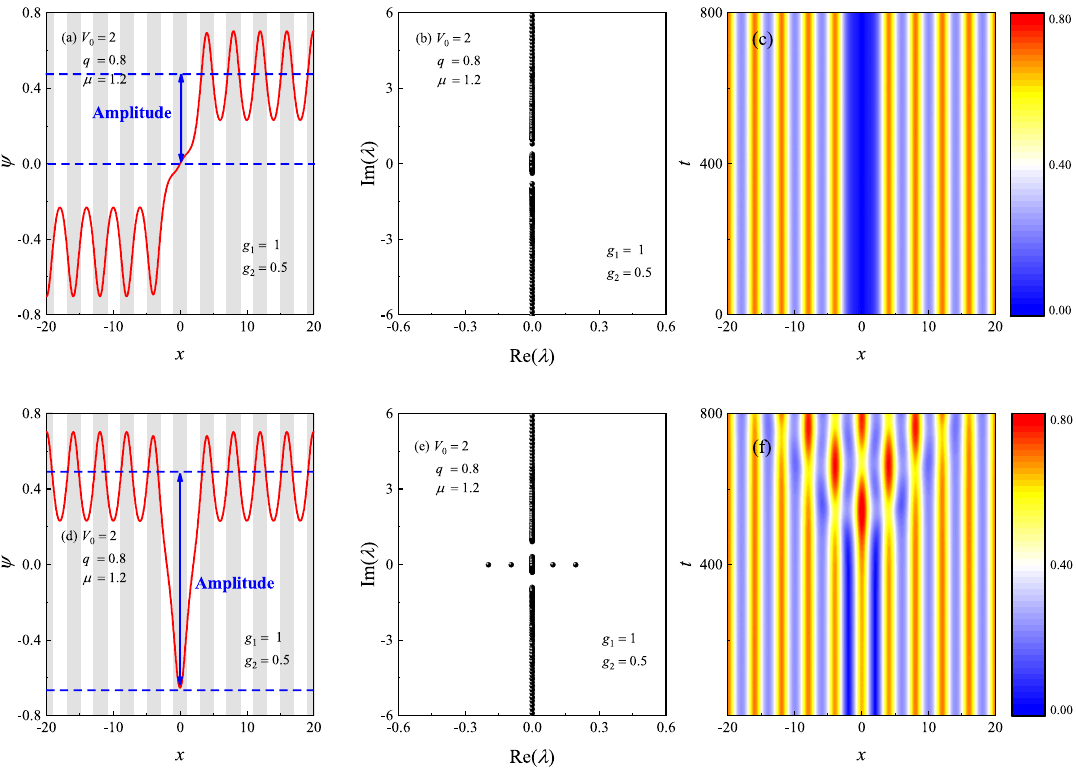
Figure 10. Profiles of ( a ) kink and ( d ) bubble in the first gap. The shaded regions represent lattice sites, i.e., regions of low potential values V ( x ). ( b , e ) The linear stability spectrum of the dark solitons shown in �( x , t ) ( a ) and ( d ), respectively. ( c , f ) Contour plots of for the dark solitons. The parameters are taken as | | 2, q 0.8, µ 1.2, g 1 1, g 2 0.5 . V 0 = = = = =